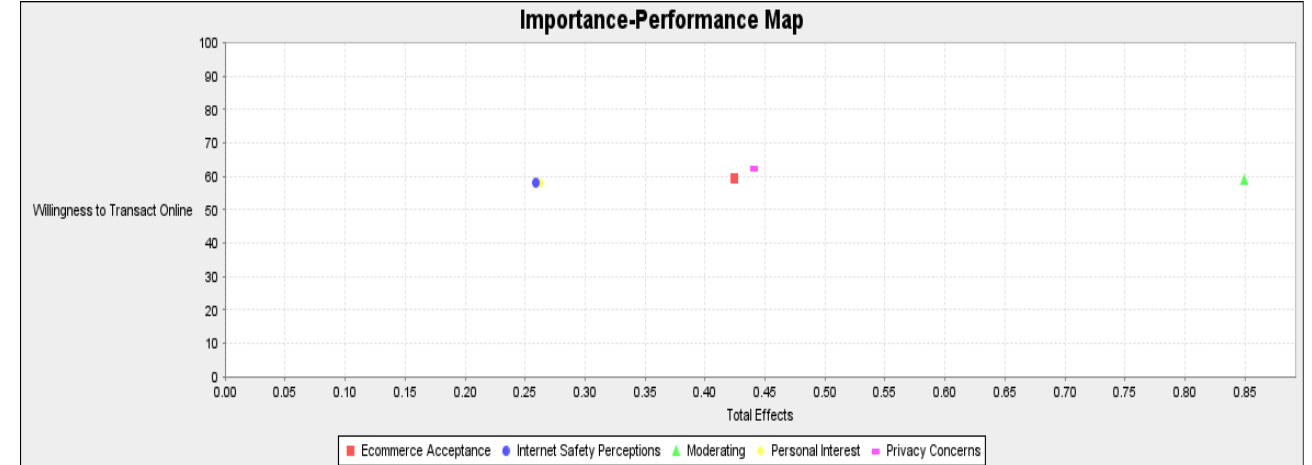
Figure 2. IPMA results .